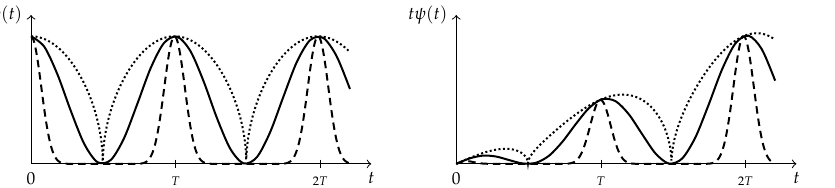
(cid:112) | cos ω t | . ( Right ): the corresponding cross-sections of